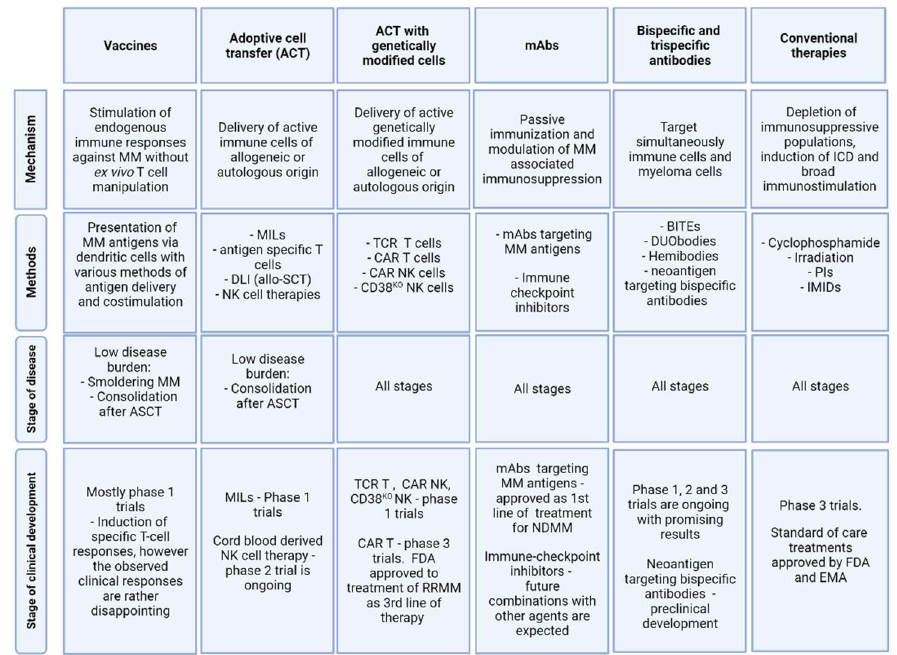
Figure 1. Overview of immunotherapeutic principles in Multiple Myeloma. ASCT: Autologous stem cell transplantation; DLI: Donor lymphocyte infusion; ICD: Immunologic cell death; IMIDs: Immunomodulatory drugs; mAbs: Monoclonal antibodies; MILs: Marrow infiltrating lymphocytes; PIs: Proteasome inhibitors.